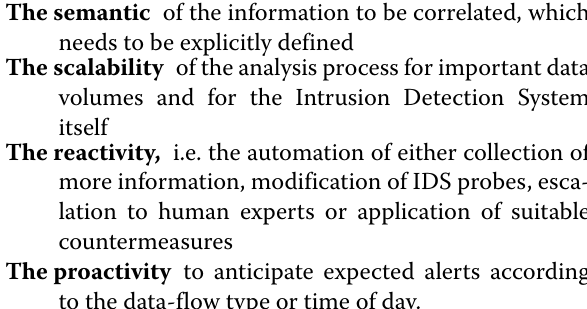
and correlation, known as the NAC process [68]. This pro- cess may be complemented by a clustering step [69, 70] to enrich detection